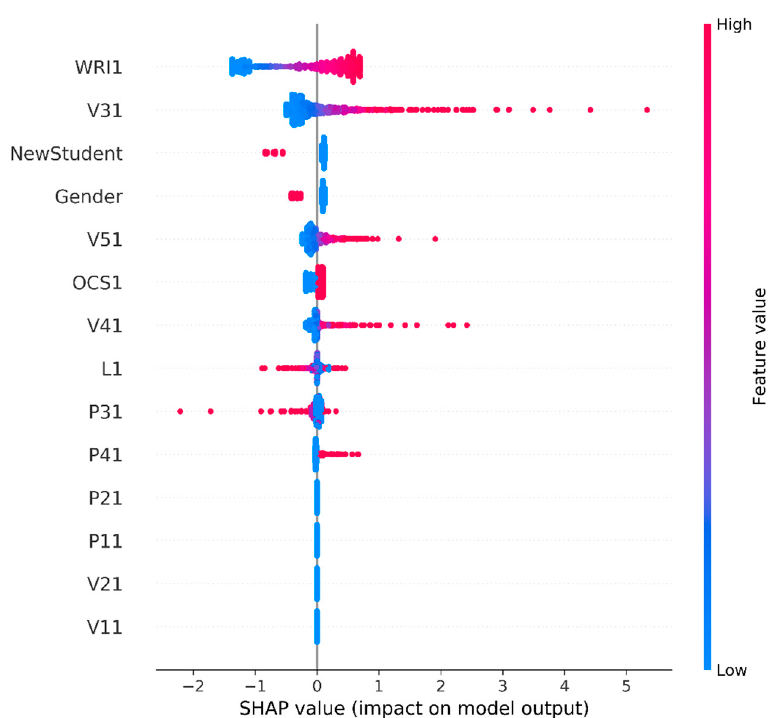
Figure 4. KernelSHAP values of the 5NN regressor ( D 1 dataset).